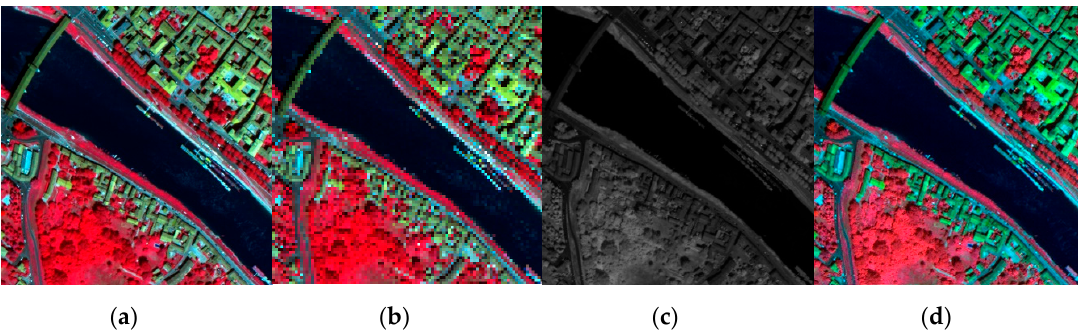
Figure 9. ( a ) RGB composites of image (bands 102, 56, and 31 for red, green, and blue, respectively). ( b ) Coarse image ( 4 S = ). ( c ) Panchromatic image. ( d ) Pansharpening result.